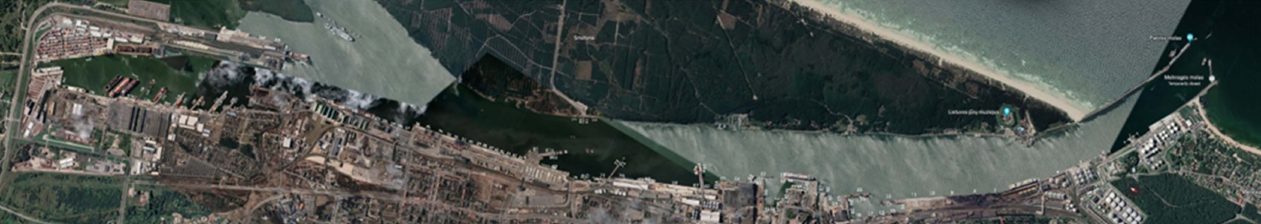
Figure 1. Klaipeda port. Orthophoto map Layer Data: Google